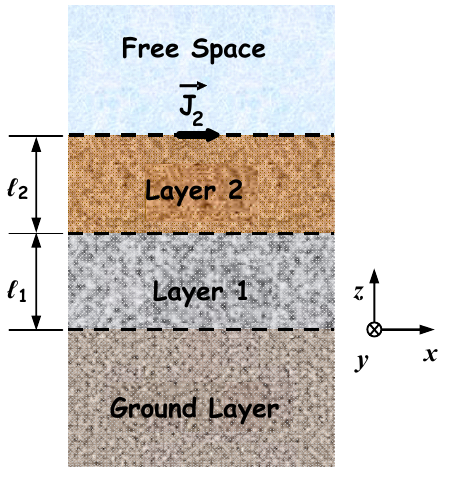
Figure 2. Geometry of a planar structure with four layers (lateral